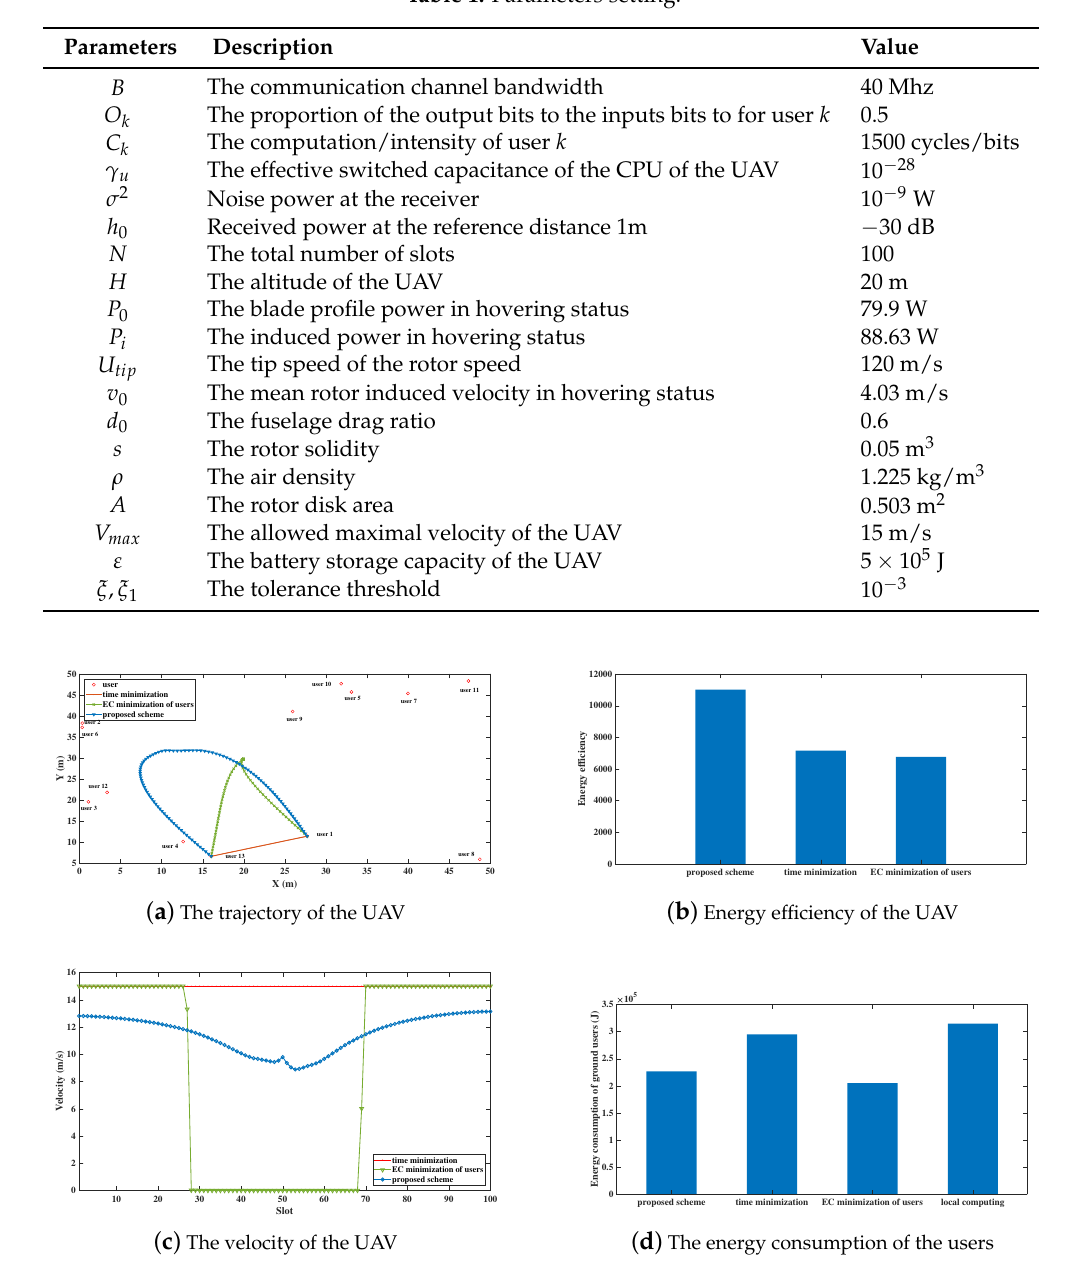
Figure 3. Performance comparison of 13 users under the proposed energy-efficient scheme and benchmark ( T = 5 s, P = 0.2